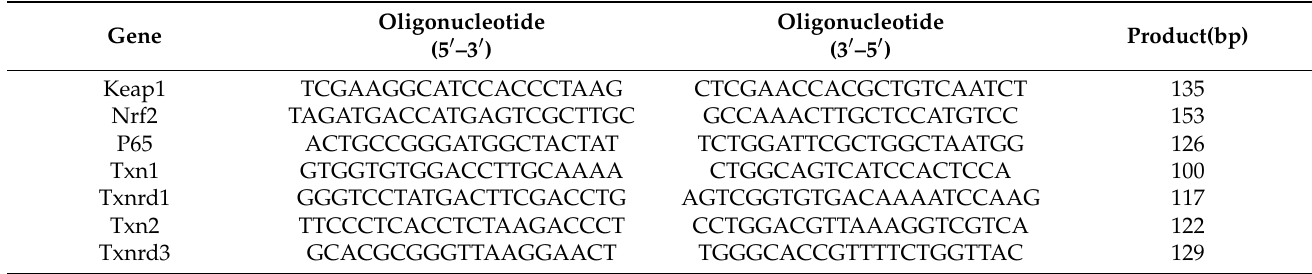
Table 1. Primers sequences used to amplify RNA